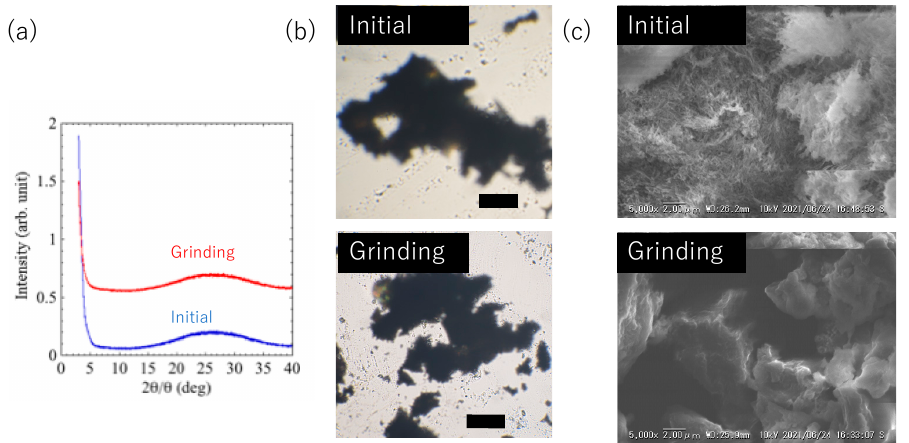
Figure 4. ( a ) X-ray diffraction (XRD) spectrum ( b ) optical image ( c ) and scanning electron microscopy (SEM) images of 2ECh before and after mechanical grinding. The black line in ( b ) is scalebar for 0.8 mm.